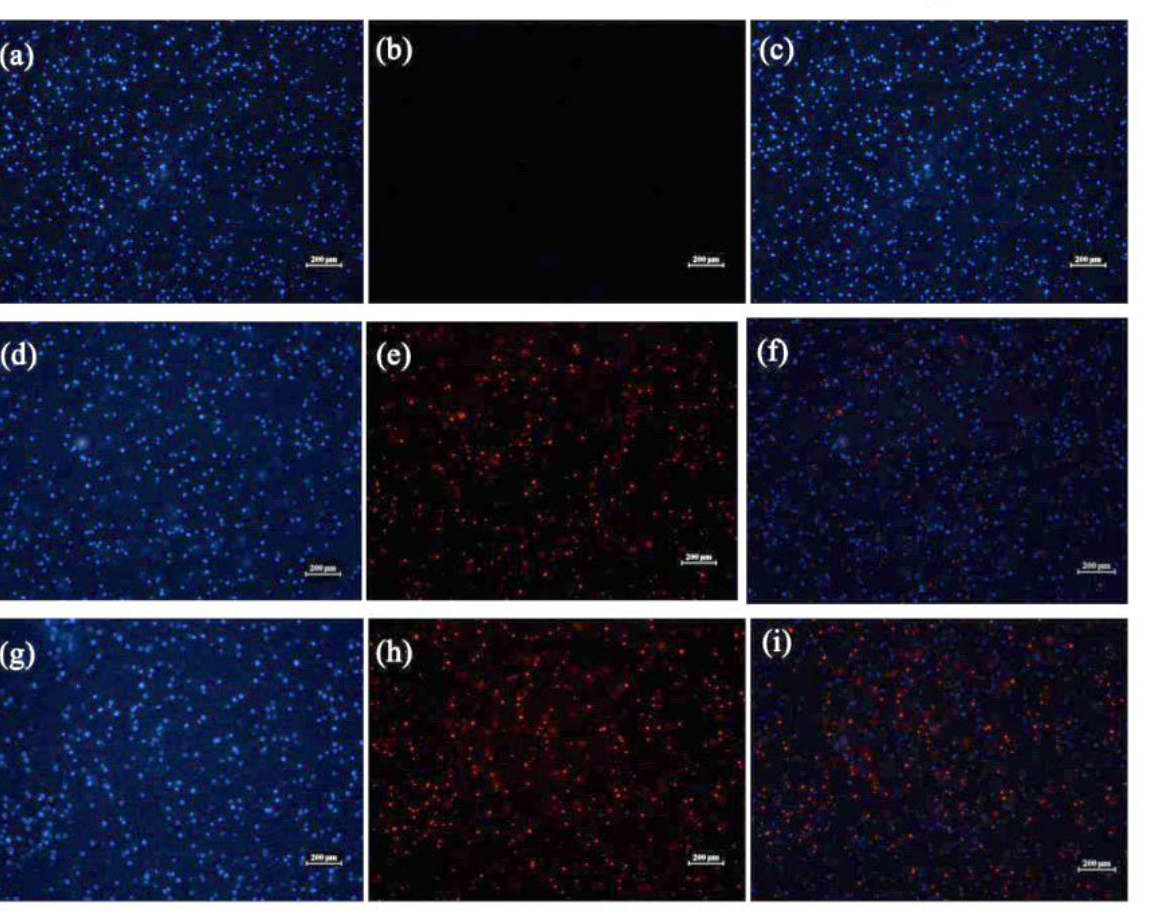
Figure 7. Fluorescence microscopy graphs of DAPI/PI staining of MRSA-3 treated with 2-fold and 4-fold MICs of 7 . ( a – c ) Non-treated with 7 (black control); ( d – f ) treated with 7 at 2× MIC; ( g – i ) treated with 7 at 4× MIC (scale bar 200 μm).